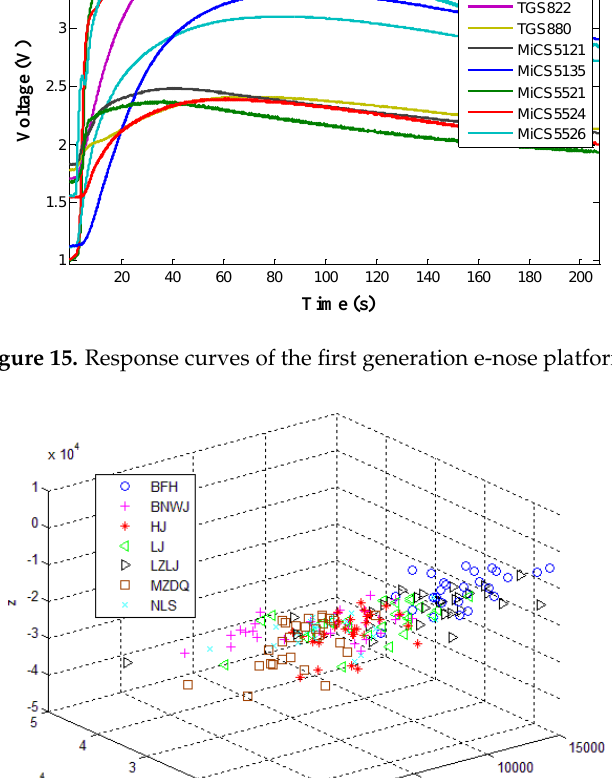
Figure 16. Three-dimensional principal component analysis (PCA) score plot.